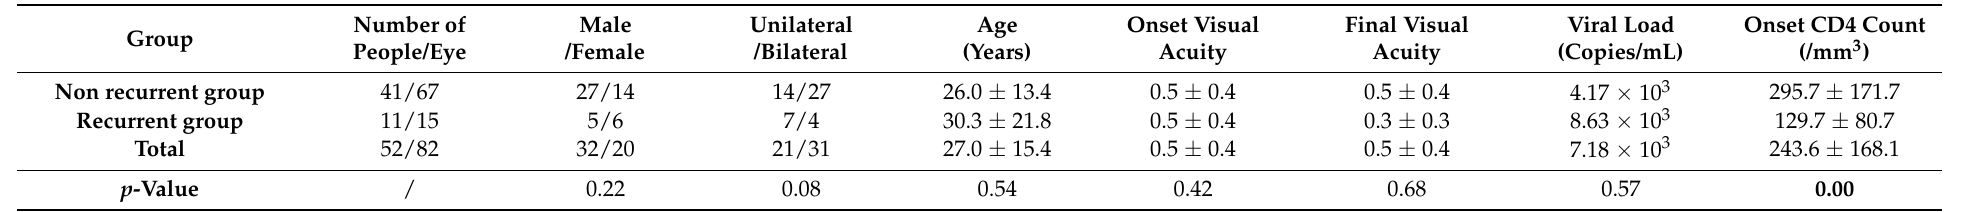
Table 1. Comparison of clinical data between recurrent and non-recurrent CMVR patients after HSCT.